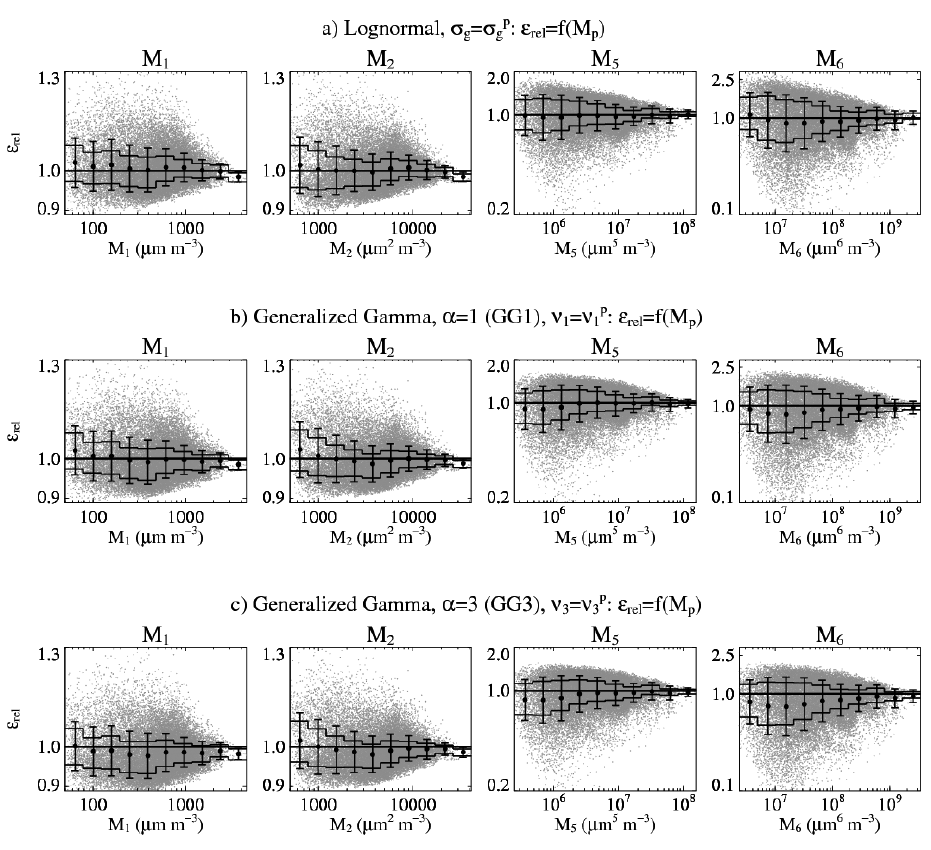
Fig. 7. Same as Fig. 4 using the proposed parameterization for the variable tuning parameter. Table 3. Same as Table 2 when using the variable tuning parameter parameterizations, σ p g for the Lognormal, ν p